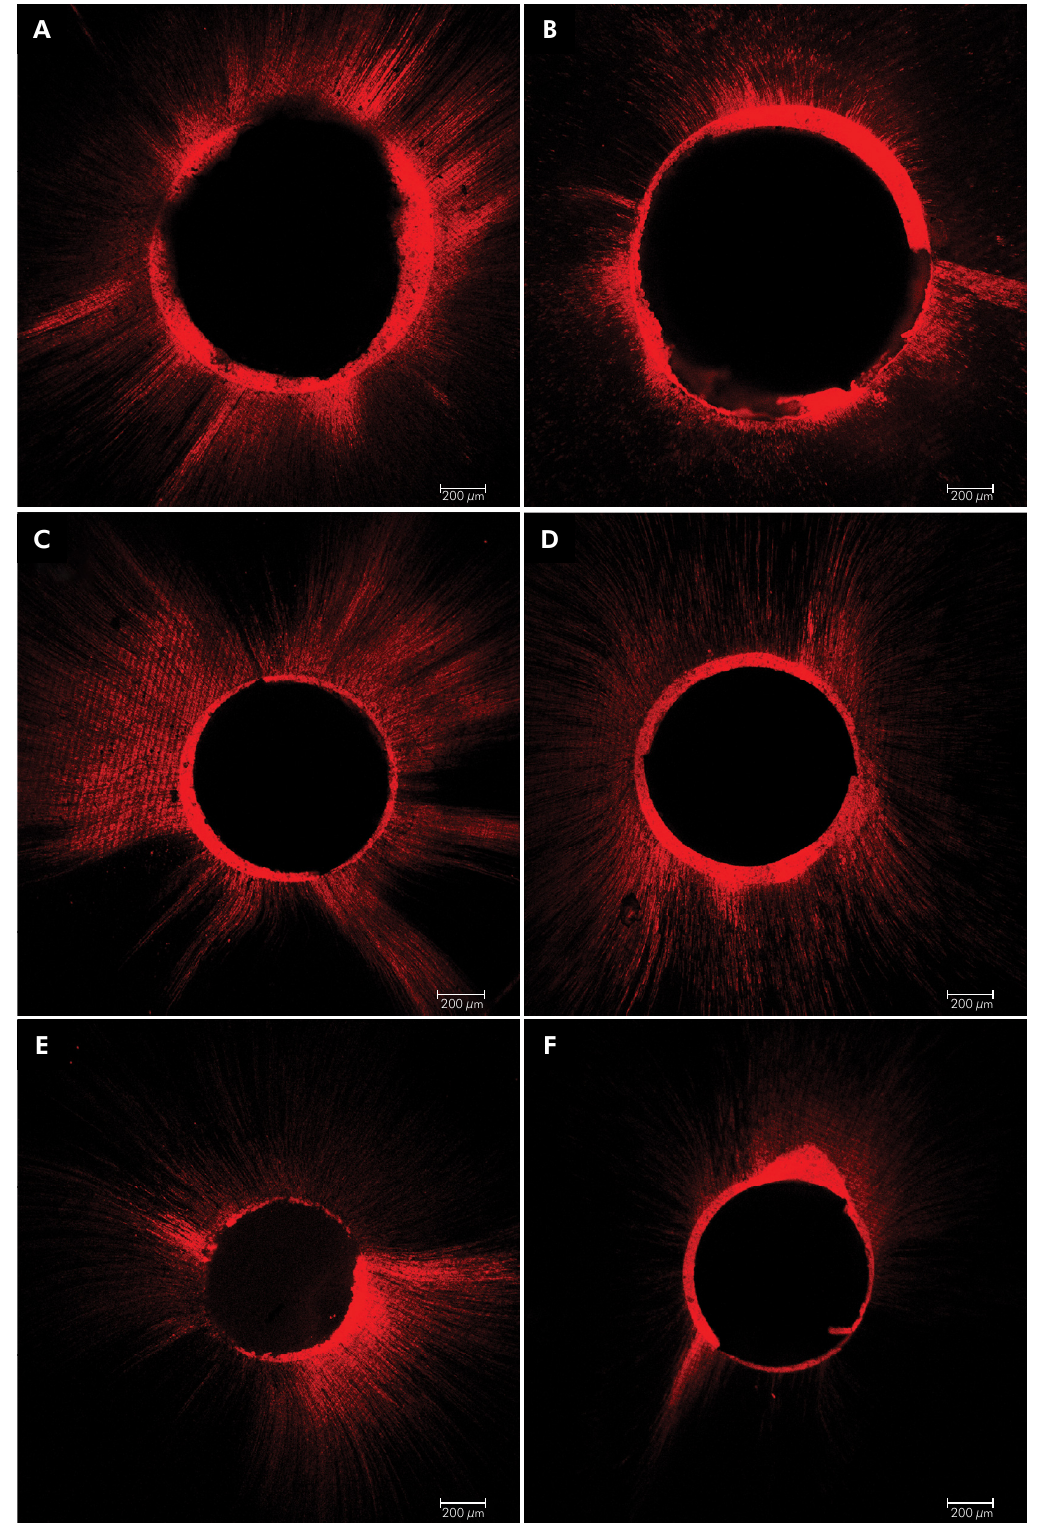
Figure 2. Penetrability of root canal sealer into dentinal tubules. Since there was no difference between PAA and NaOCl-EDTA-NaOCl groups in relation to sealer penetrability, both these groups are represented in the same image in the cervical (a), middle (c) and apical (e) thirds. The groups of NaOCl and saline are represented in the same image in the cervical (b), middle (d) and apical (f) thirds. Bar = 200 µm.